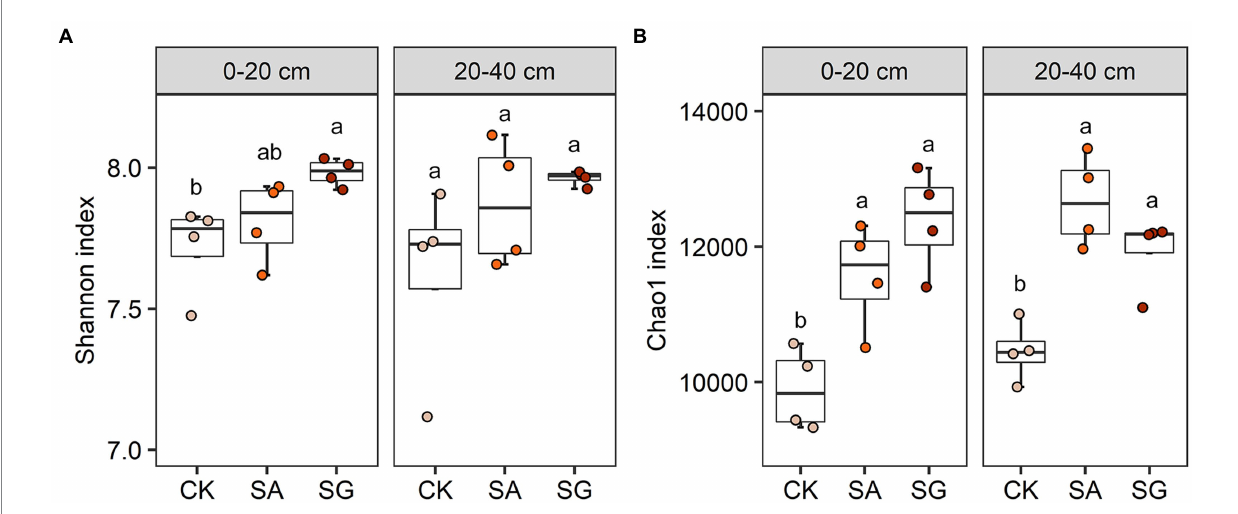
FIGURE 2 Effects of different restoration modes on bacterial alpha diversity. (A) Bacterial Shannon index and (B) bacterial Chao1 index. Error bars indicate standard deviation; different lowercase letters indicate significant differences at p < 0.05 among treatments, based on the Tukey’s honest significance difference (HSD) test.